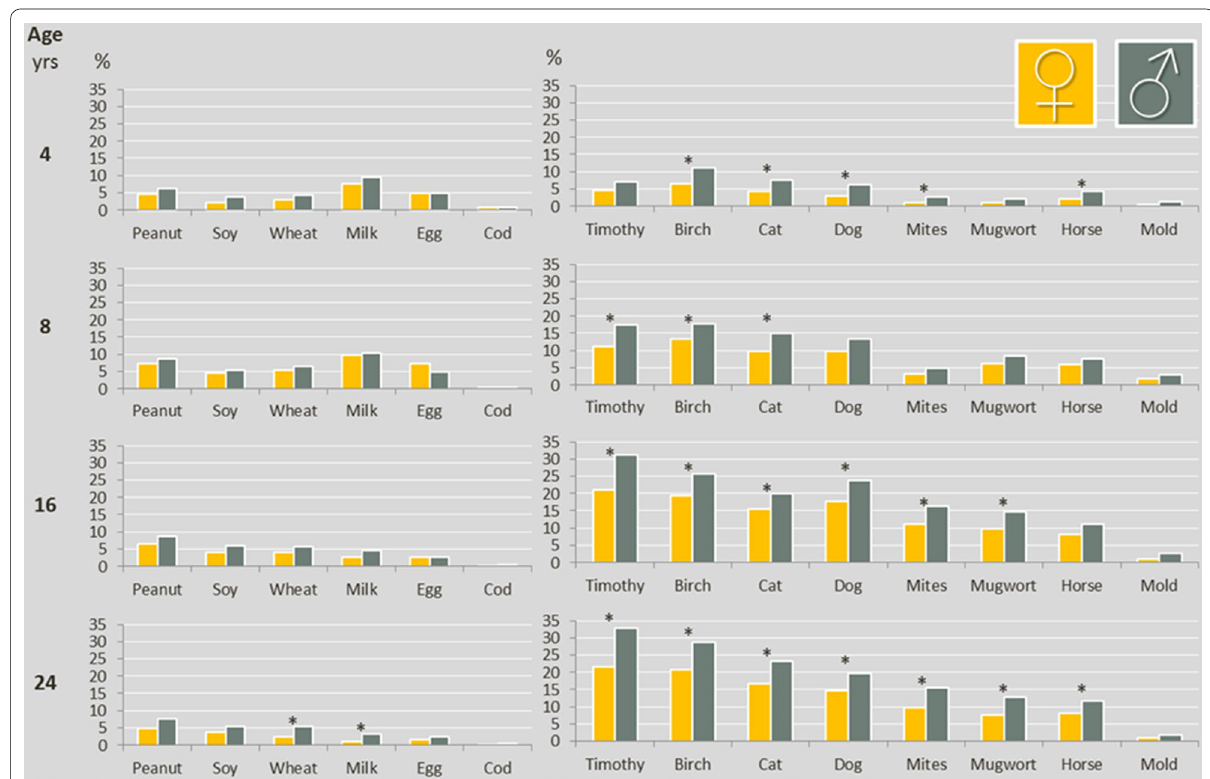
Fig. 5 Proportions of females and males with sensitization (IgE 0.35 kU A /l) to specific foods and airborne allergens at ages 4 years (n ≥ 8 years (n 2446), 16 years (n 2547) and 24 years (n 2234), in the BAMSE birth cohort. * Statistical significant difference, based on Bonferroni = = = correction (p ≤